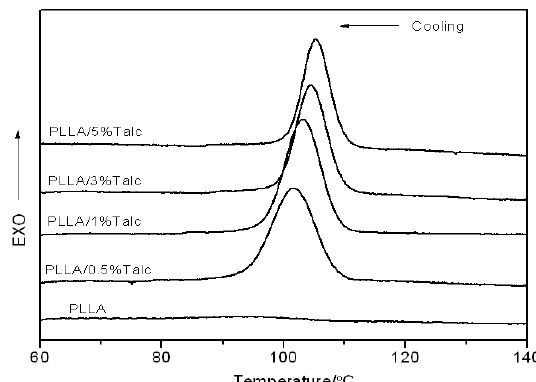
Figure 1. DSC curves of non-isothermal crystallization from melt of PLLA/Talc composites with different talc content. Table 1. DSC date of PLLA/talc composites crystallized from melt at cooling of 1 ℃ /min.